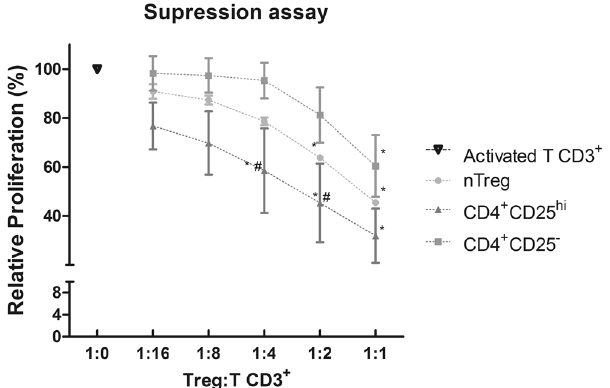
Figure 3. Immunosupressive potential of CD4 TGF/atRA iTregs and nTregs. CD4 + CD25 + CD127 dim/ − nTregs freshly isolated from peripheral blood of healthy donors and CD4 + CD25 hi iTregs sorted from CD4 TGF/atRA cultures, were cocultured with CFSE labeled CD3 + lymphocytes in different ratios (from 1:1 to 1:16; Tregs:CD3 + T-cells). The results are show as the percent of proliferation of CD3 + T lymphocytes in the presence of Tregs, as compared to CD3 + T-lymphocytes proliferating alone. Bars indicate mean and SEM of three separate experiments. The statistical test used to compare the percentage of suppression was Two-way ANOVA with a Bonferroni post-test. * Significance (p < 0.05) relative to CD3 + T lymphocytes; # Significance (p < 0.05) relative to CD4 + CD25 −